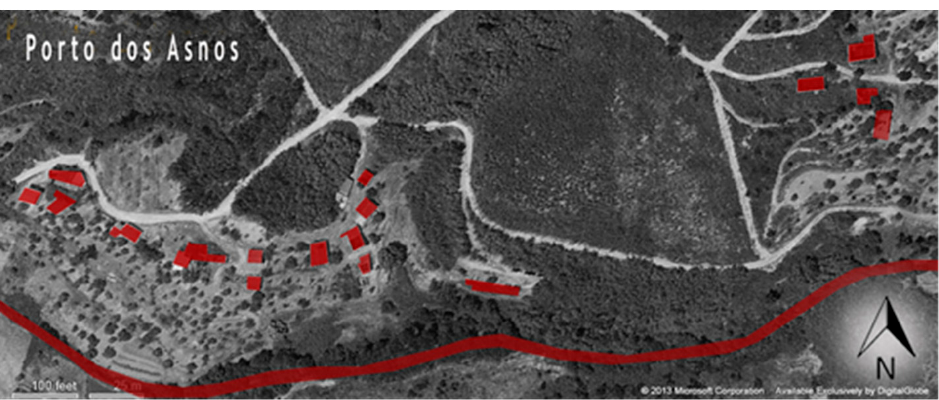
Figure 1. Deployment plan for the cluster along the waterline.